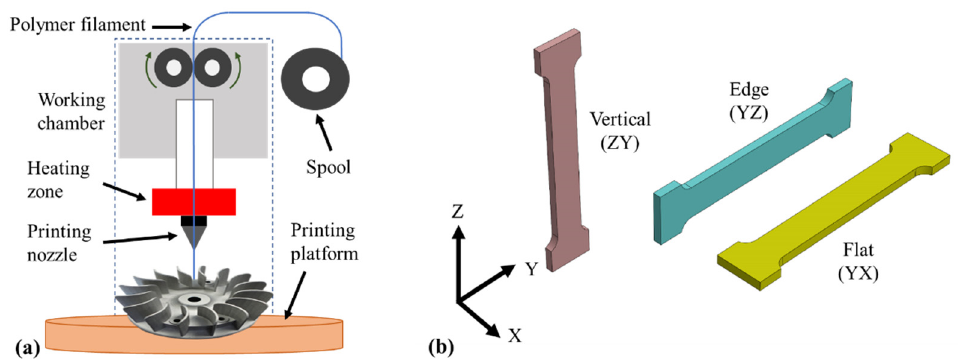
Figure 1. ( a ) FDM schematic diagram and ( b ) build orientation.